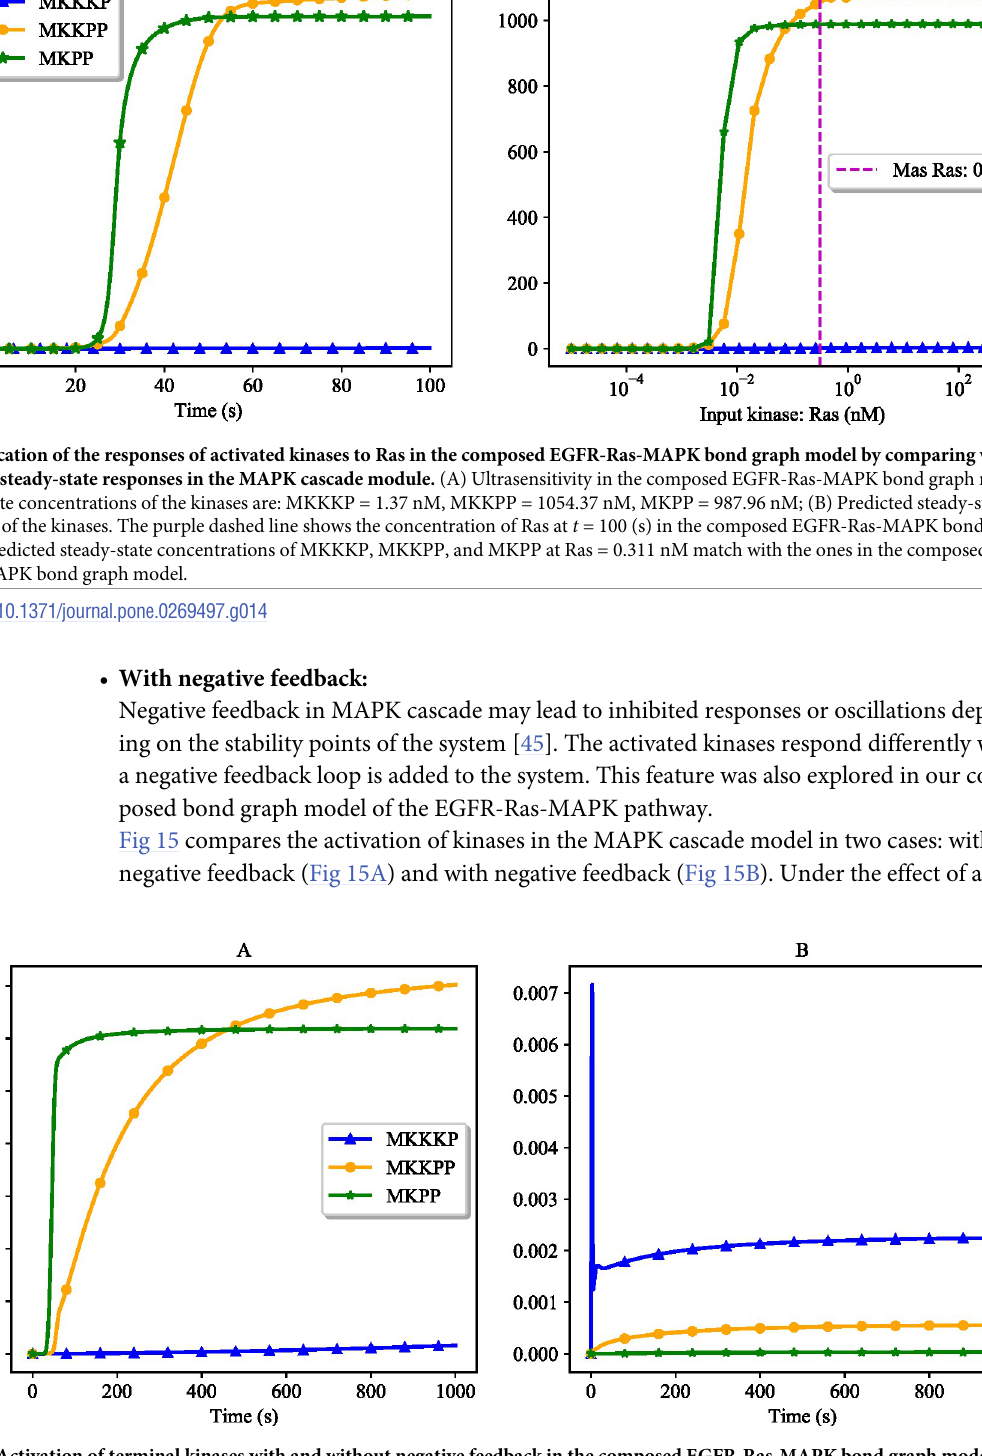
Fig 15. Activation of terminal kinases with and without negative feedback in the composed EGFR-Ras-MAPK bond graph model. (A) Without negative feedback; (B) With negative feedback.